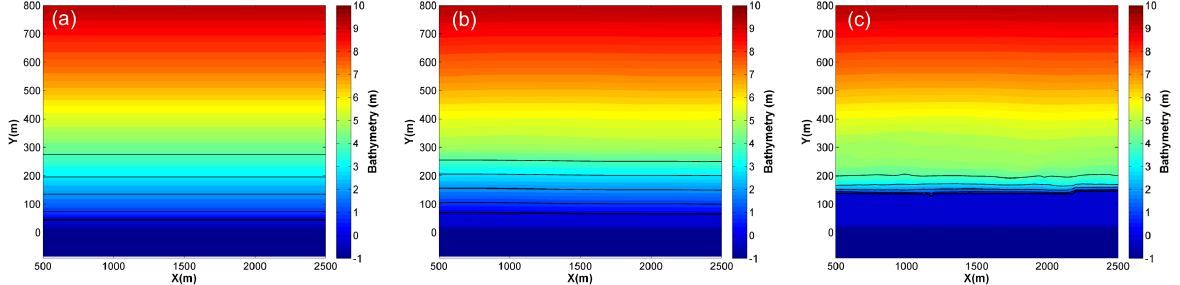
Figure 1. Initial bathymetry (a) and bathymetries after 9 years of morphological evolution considering the bed slope correction (b) and without the bed slope correction (c) . The thicker isoline in the bathymetry represents the shoreline, whereas the remaining ones represent the 1, 2, 3, and 4m isobaths.